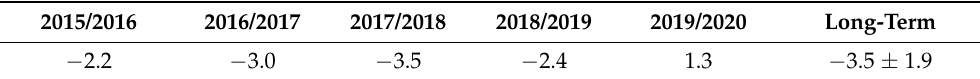
Table 2. Mean winter air temperature (1 November–31 March) in the 2015–2020 period as well as the mean long-term value with standard deviation ( ± SD) of air temperature at meteorological station “Toropets” ( ◦ C)